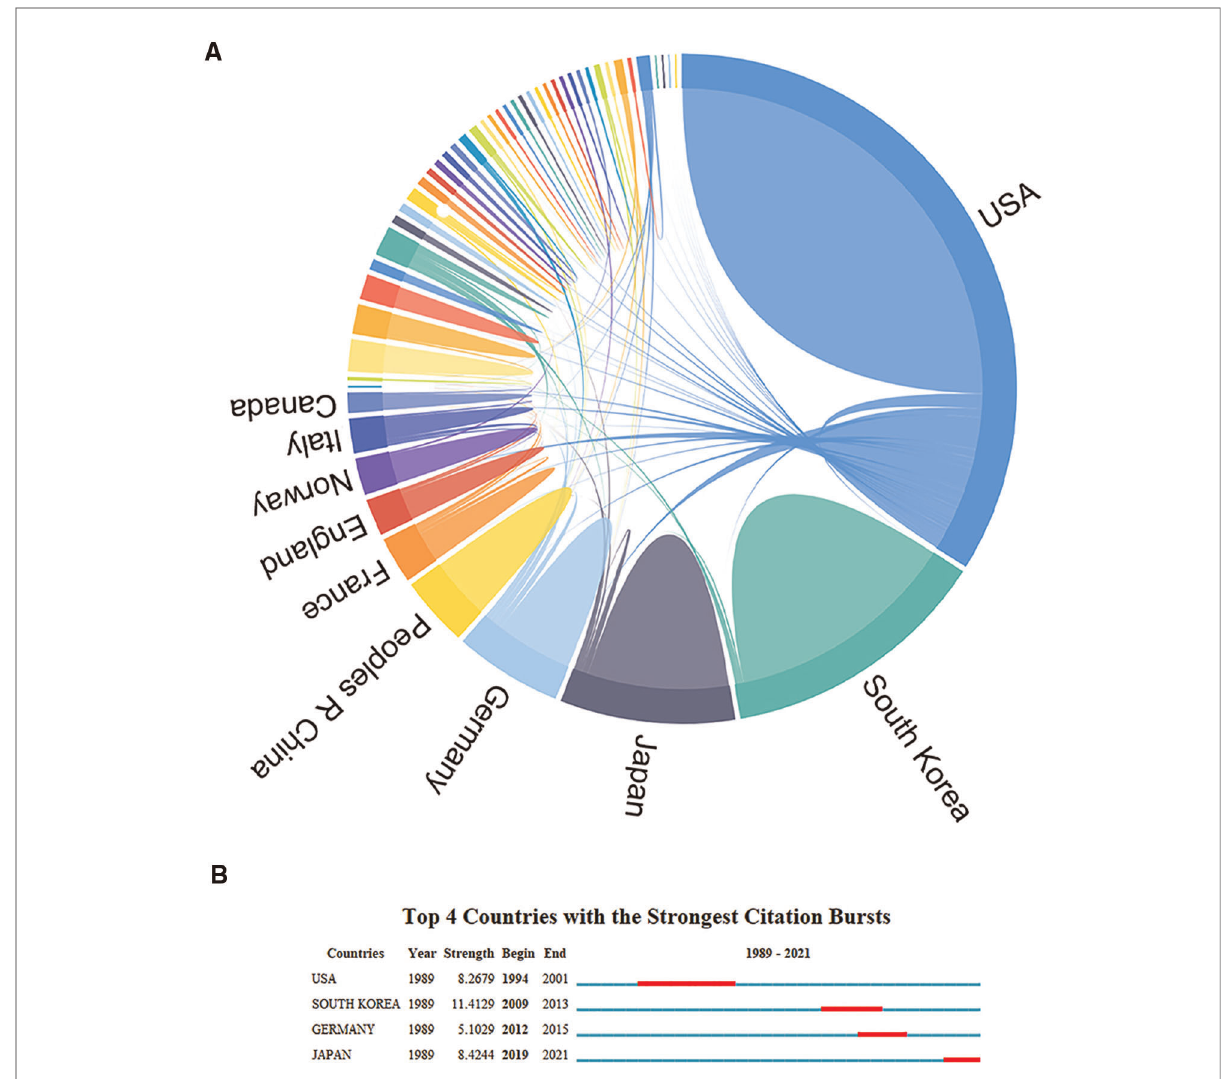
FIGURE 2 Scienti fi c collaboration network among countries for meniscal root tears research. ( A ) Chord diagram of cooperation network of the publishing countries. ( B ) The strongest citation bursts of countries.